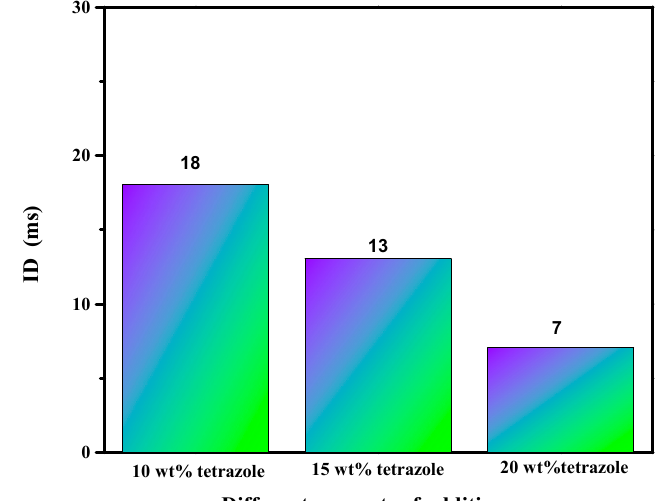
Figure 13. ID time of mixtures.